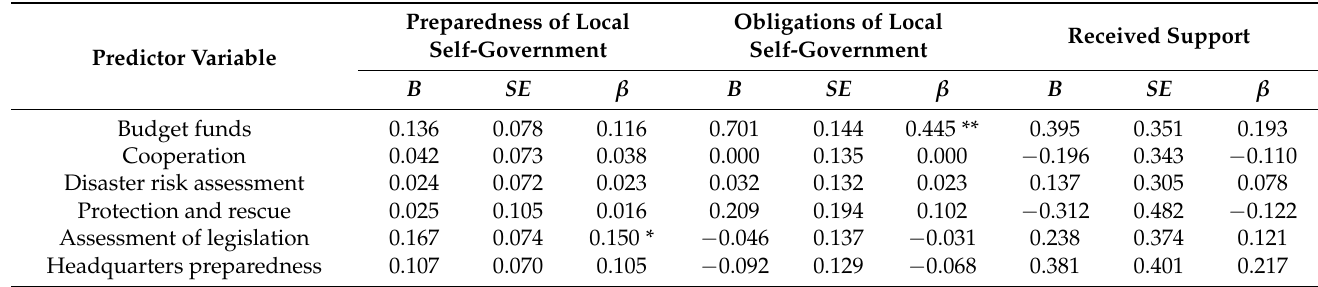
Table 2. Results of a multivariate regression analysis of the capacity development of local self-governments for DRR.